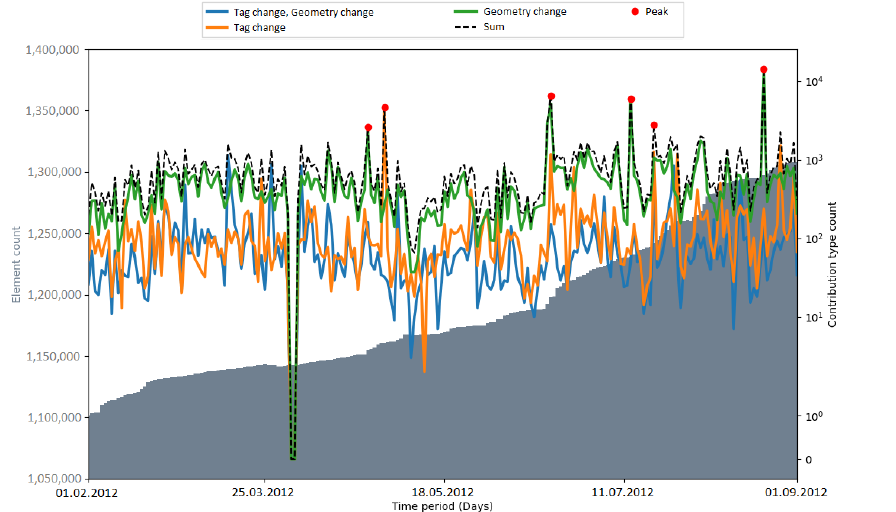
Figure A15. Contribution types during the observation period without a large data import in India.